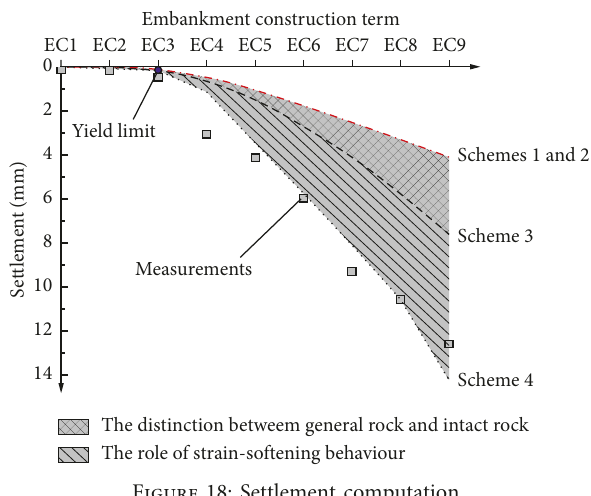
Figure 18: Settlement